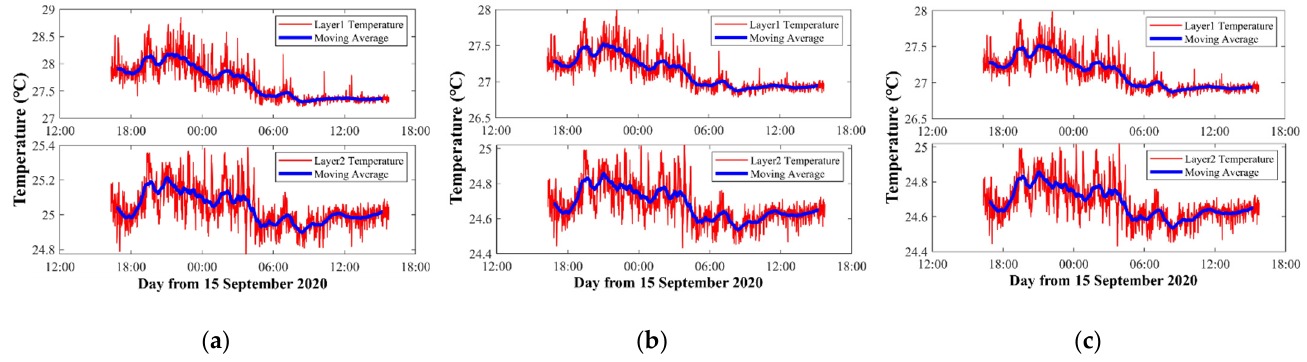
Figure 9. Two layers’ average temperatures along vertical slice. ( a ) Layer division results of Number 2 ‐ 2. The pvtem ‐ er was smaller than 0.8 °C. ( b ) Layer division results of Number 2 ‐ 3. The pvtem ‐ er was smaller than 0.8 °C. ( c ) Layer division results of Number 2 ‐ 3. The pvtem ‐ er was smaller than 0.05 °C.